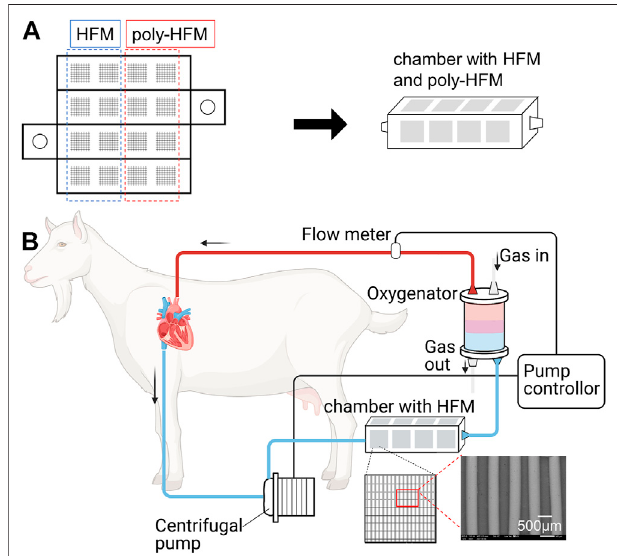
FIGURE 3 | (A) Development of a chamber of acrylic plates pasted with membranesmadeofhollow fi bers(HFM)of1.0×1.0 cm.Eight piecesofHFM were coated with the cross-MPC copolymer (poly-HFM). (B) Schematic illustration of in-vivo experiment for evaluating the blood compatibility. The chamber was connected to the ECMO system in series. The centrifugal pump in ECMO system was controlled from 1.0 to 2.0 L/min.